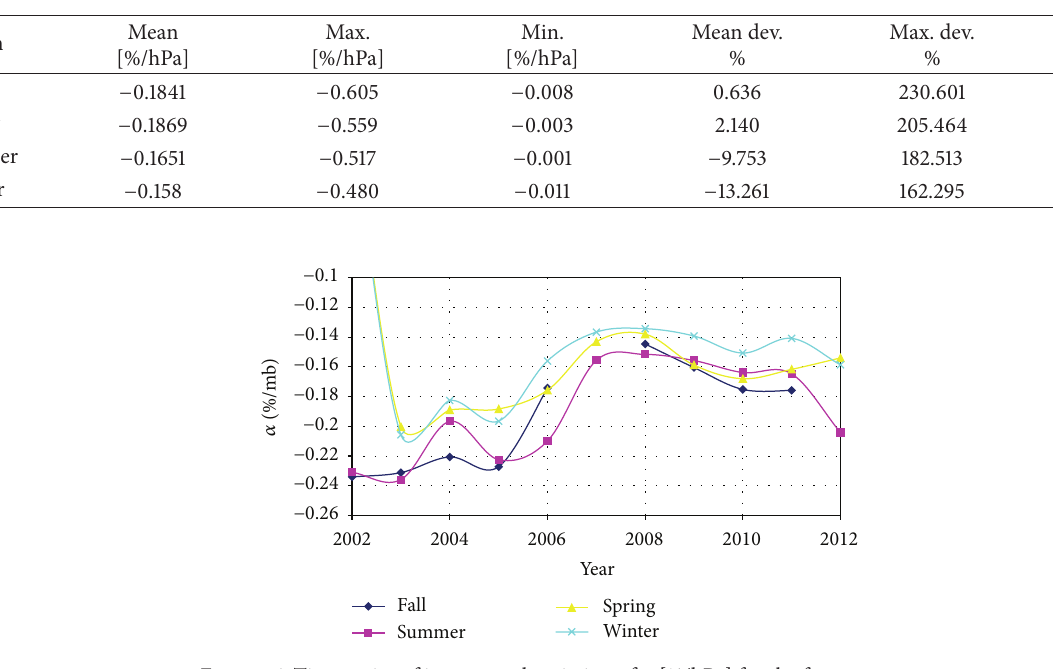
Table 1: Summarization of the mean, maximum, and minimum values of 𝛼 for the four seasons. The last three columns are mean, minimum, and maximum deviations of 𝛼 from the 𝛼 11 .